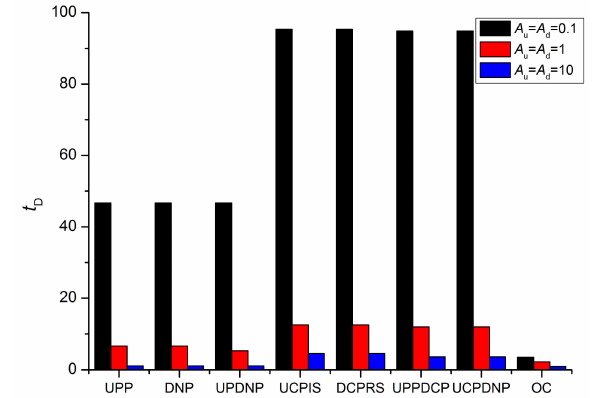
Figure 3. Pressure equilibrium times for homogeneous